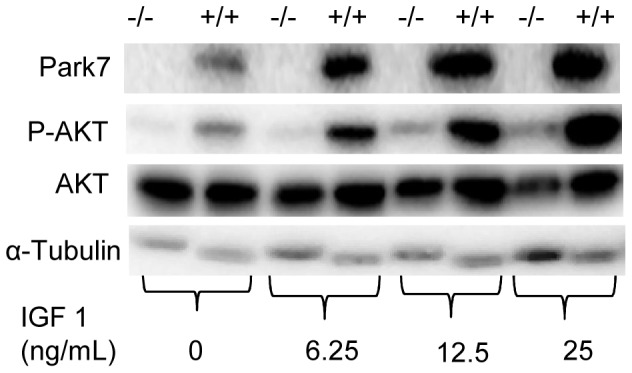
Phosphorylation of AKT (S473) protein in Park7 (+/+) and Park7 (−/−) myotubes.Myoblasts were induced to differentiation for 72 hours and treated with IGF1 at the indicated concentrations for 15 minutes. There was increased phosphorylation of AKT (P-AKT) in Park7 (+/+) myotubes relative to total AKT (AKT) in myotubes in fusion medium (5% horse serum). There was a substantial increase in AKT phosphorylation in Park7 (+/+) myotubes relative to Park7 (−/−) myotubes at all IGF1 concentrations. α-Tubulin was the control for protein loading.